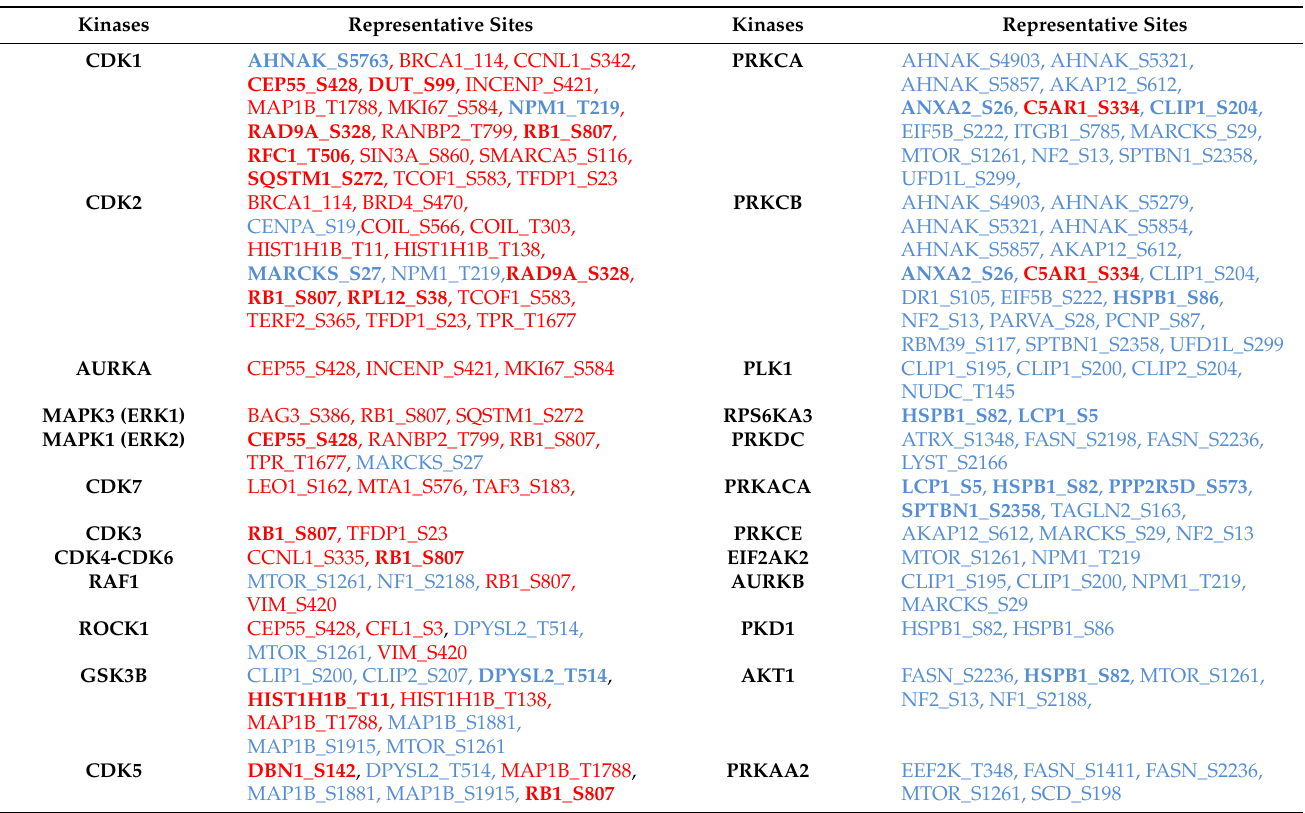
Table 1. Principal substrates and phosphosites regulated by kinases following KSEA analysis. Phos- phosites emphasized in bold letters were also obtained from KEA2 and/or iPTMNet analysis. Phos- phosites increasing phosphorylation are in red and decreasing phosphorylation is in blue. Gene symbols and the position of phosphosite in each protein are shown.